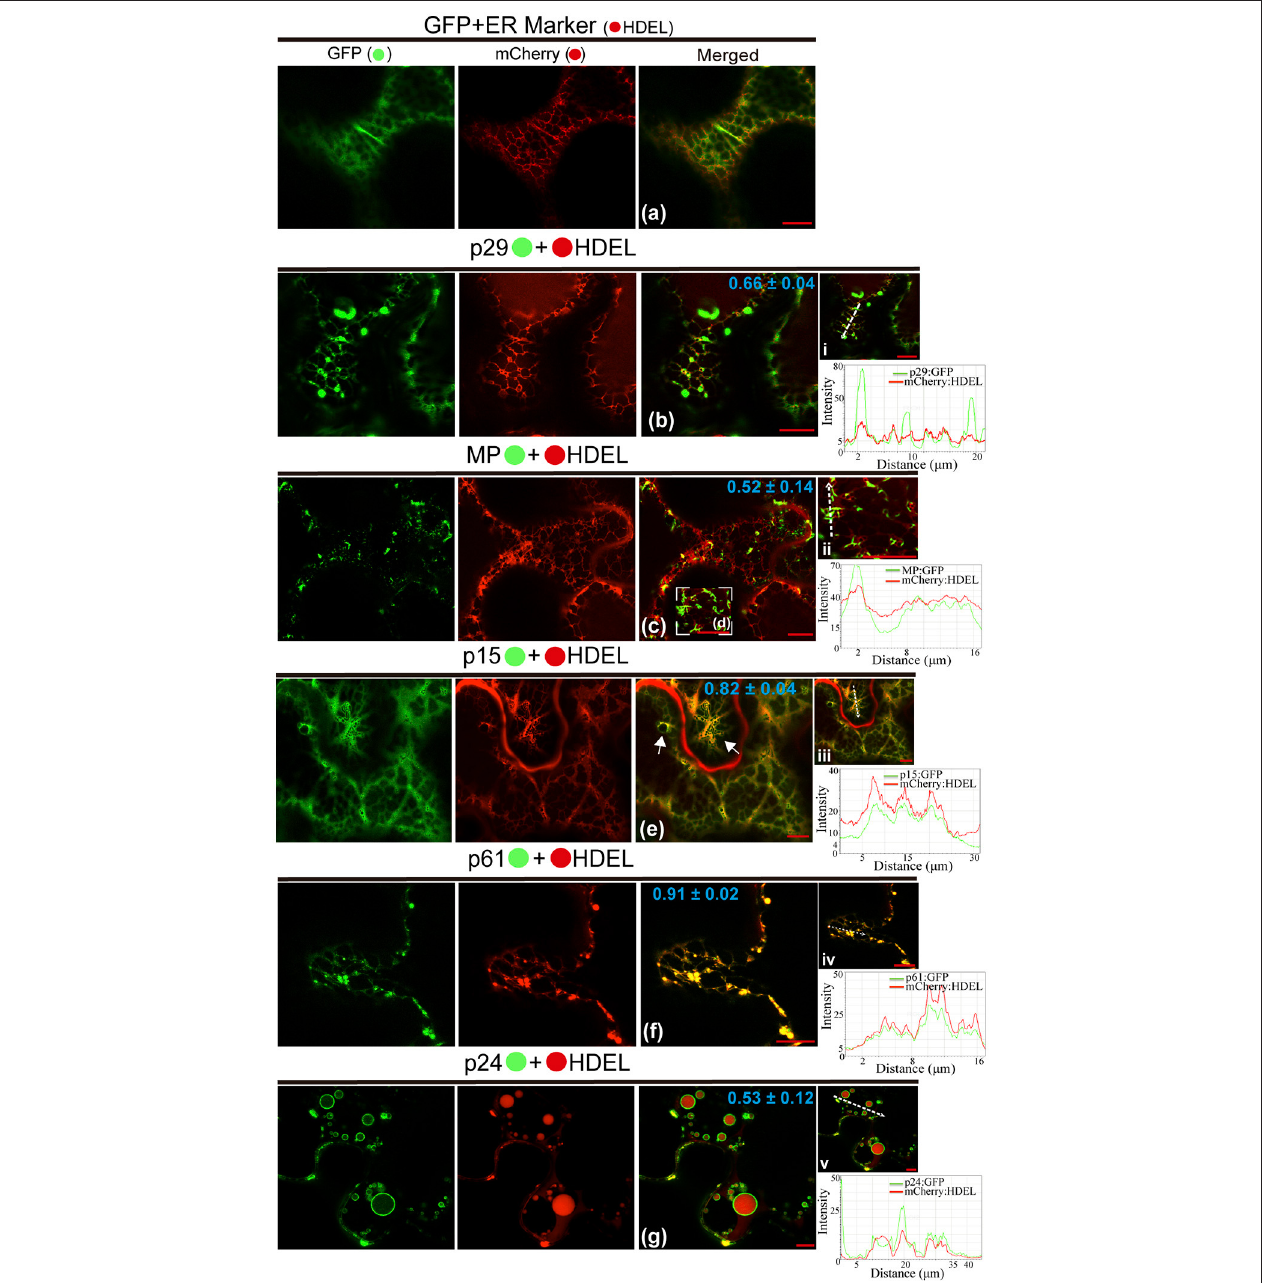
FIGURE 3 | CiLV-C proteins associate with ER and p15, p61, and p24 remodel ER network. The p29, p15, p61, MP, and p24 proteins fused at their C-termini with eGFP (•) were co-expressed with mCherry(•)-HDEL (ER marker) in epidermal cells of N. benthamiana . Fluorescence signals were captured 72h post-infiltration (except for p61, captured 24–36 hpi) with confocal microscope Leica SP8 model. The green (GFP), red (mCherry) channels and merged images are shown for each CiLV-C protein expressed with ER marker. (a) Image shows unfused GFP expression in a diffuse signal evenly distributed in the cytoplasm, where an intact ER network is observed. (b) Image shows p29:eGFP expression in punctate bodies co-localizing with ER. (c,d) Co-localization of the MP:eGFP filamentous aggregates with ER network, without apparent ER changes. (e) ER remodeling is observed from expression of the p15:eGFP with the formation of pleomorphic structures (arrows) throughout the ER cisternae. (f) Co-localization of the p61:eGFP and ER showing deformation in the ER cisternae with the formation of globular bodies along the ER. (g) Merged image shows that p24:eGFP expression completely remodel the ER, reorganizing it in vesicle-like spherical structures surrounded by the protein. The mean SD of Person Correlation Coefficient (PCC) is given in the merged image. Intensity profiles along the line segments, shown in the images on the right and represented by graphs, demonstrate positive co-localization in i, ii, iii, iv, and v. Plot shows green and red fluorescence intensities, indicated by (CiLV-C-Proteins):GFP and ER:mCherry, in the selected region of interest (dotted arrows). Distance measurement starts from the base to the tip of the arrows (x axis). Fluorescence intensity graphs were generated using Leica LAS AF quantify intensity tool. Red bar correspond to 10.